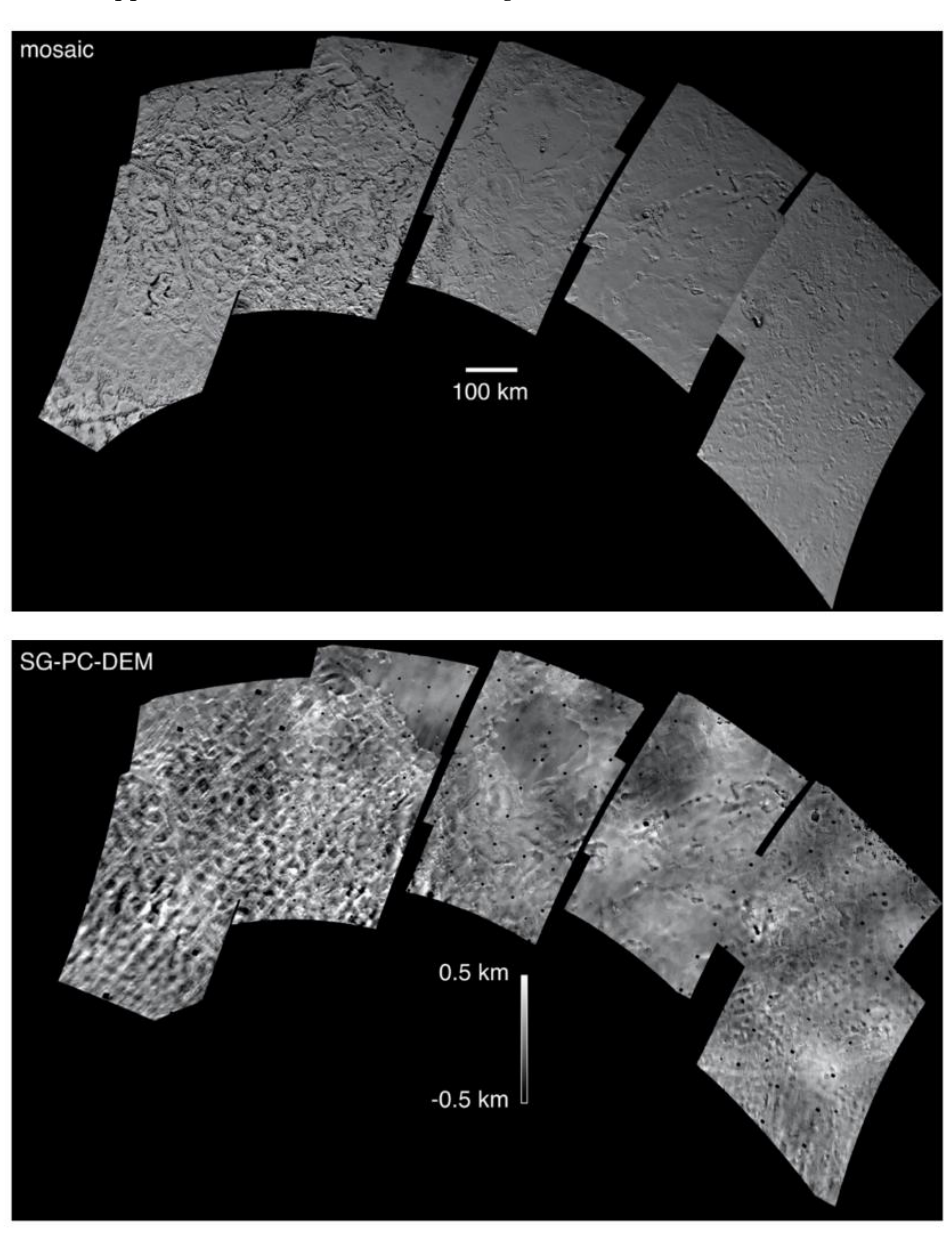
Figure 8. Merged SG-PC DEM corresponding with the VTERM highest resolution mosaic of